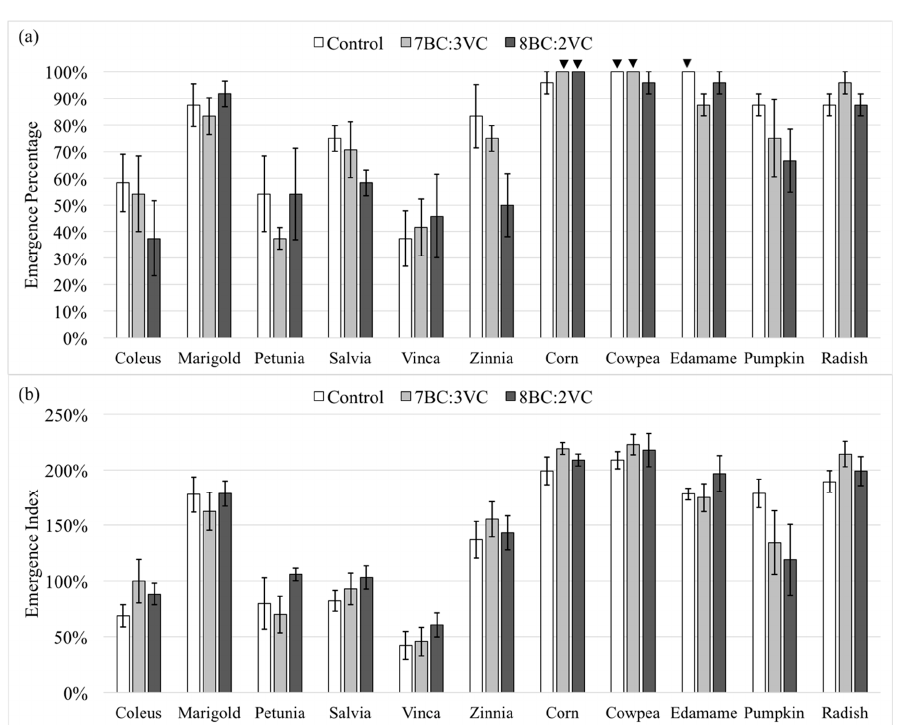
Figure 2. Seeds’ emergence percentages ( a ) and emergence indexes ( b ) (mean ± standard error) in commercial propagation mix (control), 70% biochar:30% vermicompost (7BC:3VC, by volume), or 8BC:2VC in Experiment 2. Means indicated by “ (cid:31) ” are 100% ± 0.